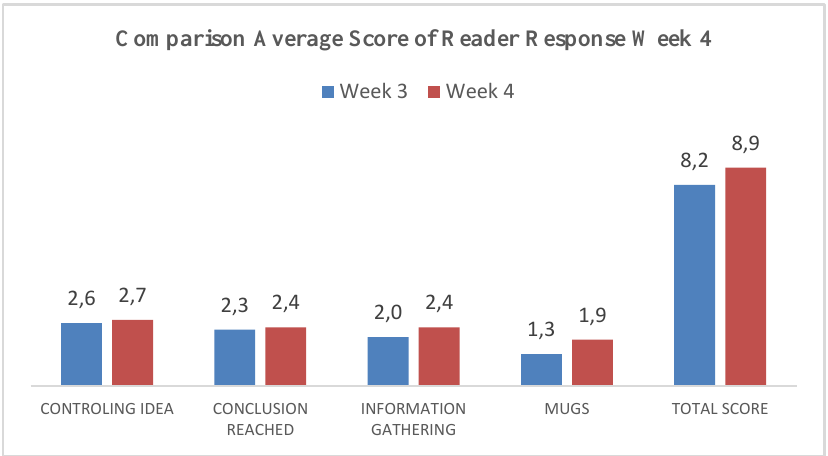
Chart 4: Average score of reader response week 3 and week